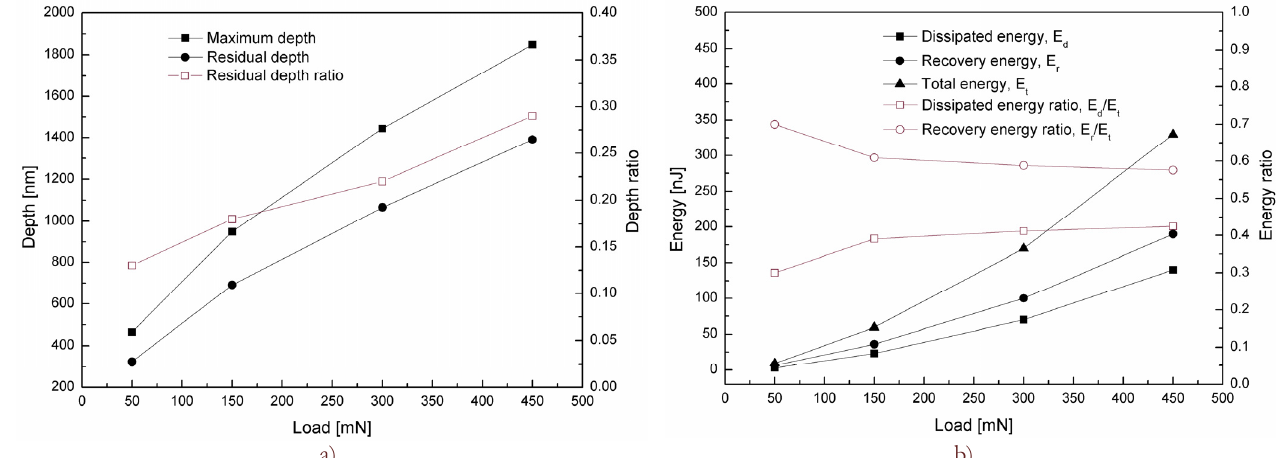
Figure 5. Recovery and residual capability of the SMA after unloading: a) depth recovery and b) energy